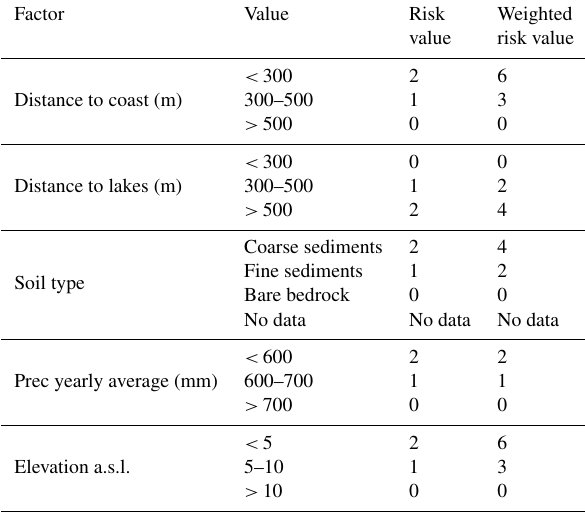
Table 1. Factors included in the risk analysis for saltwater